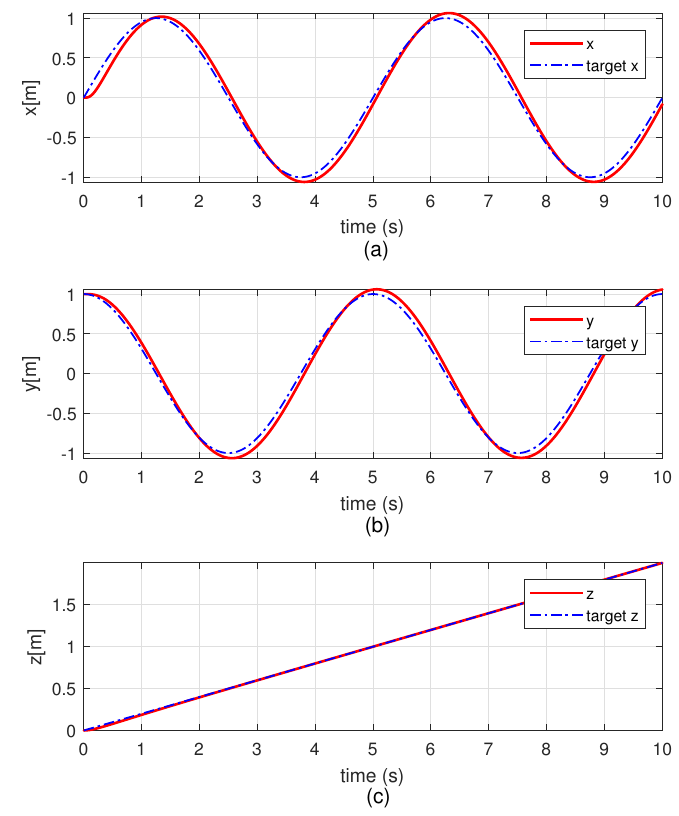
Figure 9. The trajectory tracking control results for each of the three axes. The dashed line indicates the reference trajectory of each axis, and the solid line is the result of the simulation about each axis: ( a ) x ; ( b ) y ; ( c ) z